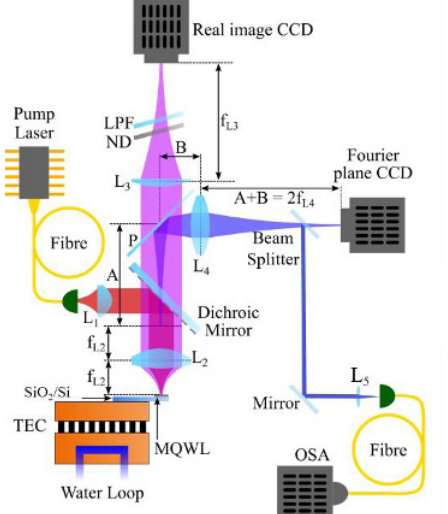
Fig. 1. MQWL experimental setup (modified from